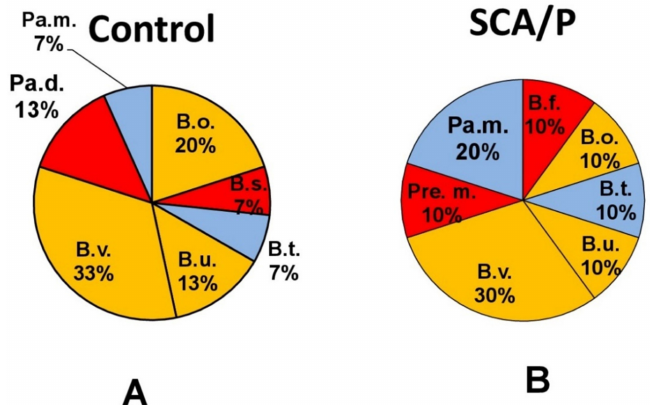
Figure 1. Prevalence of bacterial species in control subjects ( A ) and SCA / P patients ( B ) .